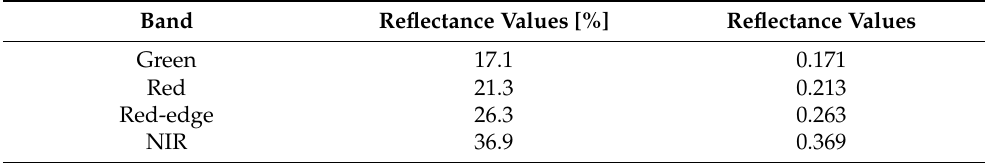
Table 6. Reflectance values for the green, red, red-edge and near-infrared bands of the multiSPEC 4c camera. Band Reflectance Values [%] Reflectance Values Green 17.12 0.1712 Red 20.32 0.2032 Red-edge 24.68 0.2468 NIR 35.13